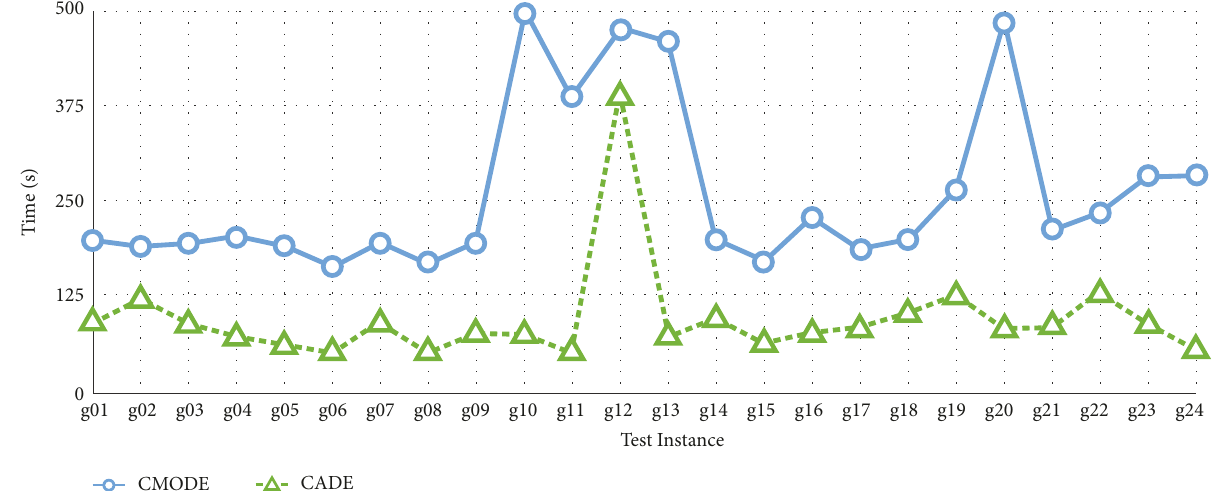
Figure 5: Comparison of CPU time spent by CMODE and